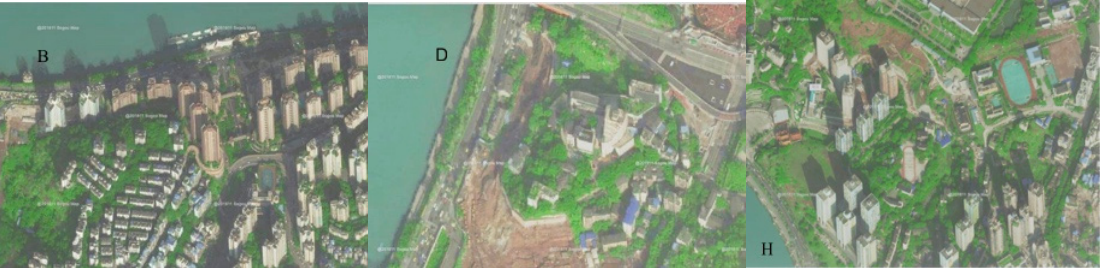
Figure 5. Typical urban environment and architectural layout near the four measuring points (B, D, H).